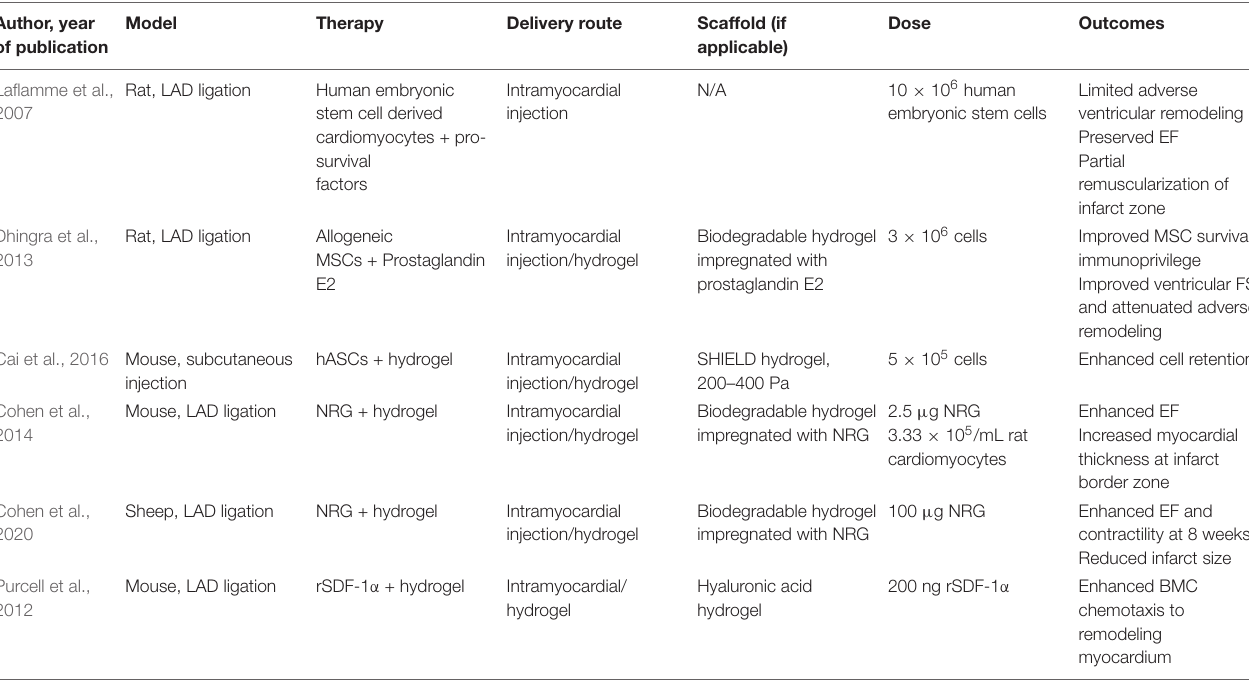
TABLE 3 | In vivo biomaterial engineering approaches to myocardial